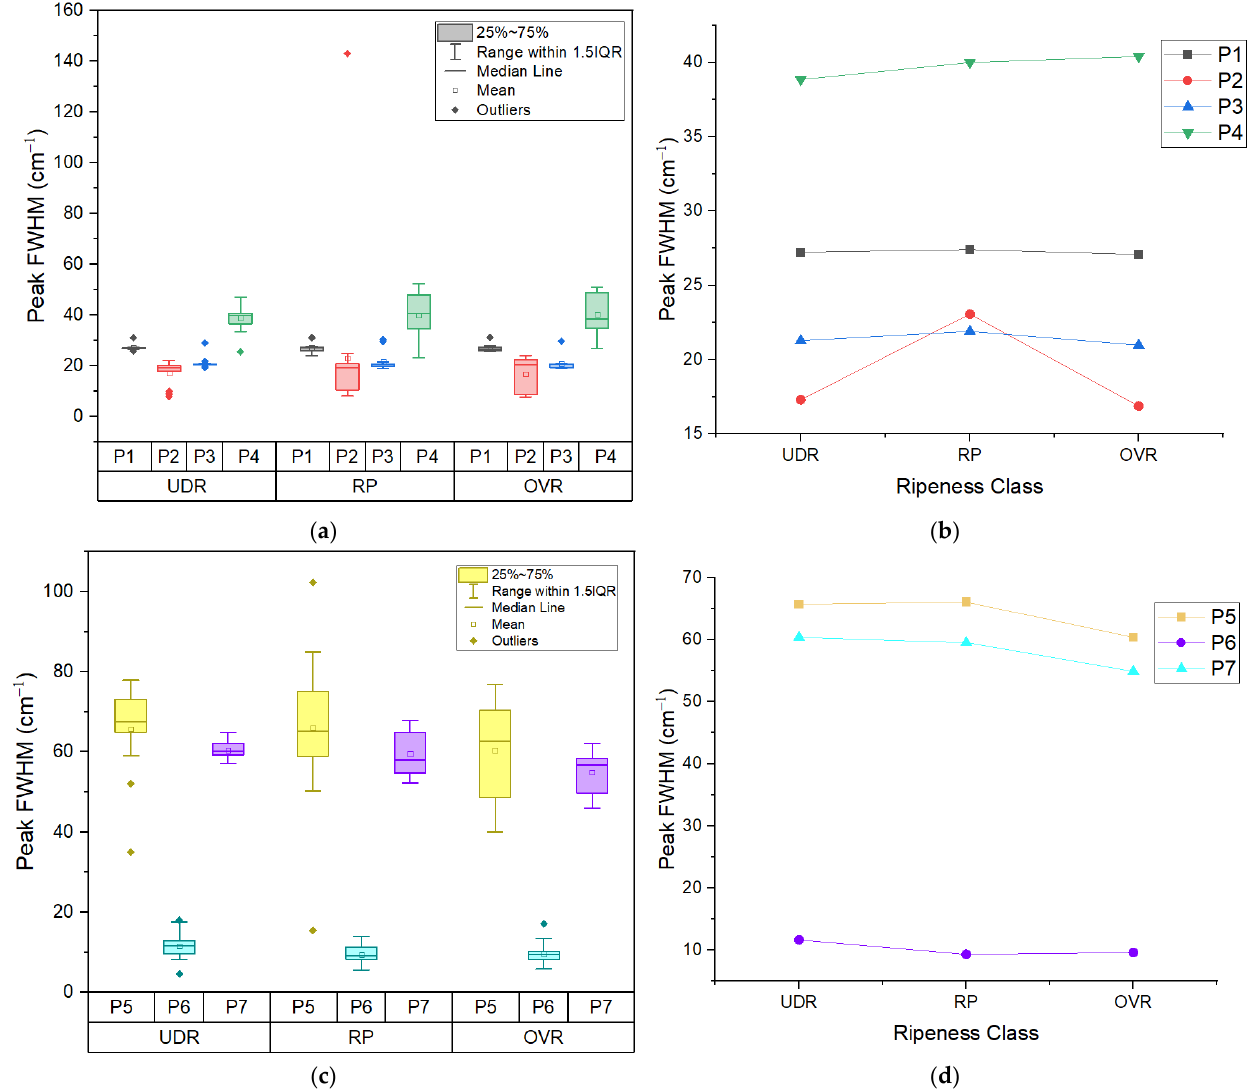
Figure 7. ( a ) Grouped box plot and ( b ) mean plot of peak’s FWHM of 4 peaks in Area 1; ( c ) Grouped box plot and ( d ) mean plot of peak’s FWHM of 3 peaks in Area 2. UDR: Under ripe, RP: Ripe, OVR: Over ripe; P1: β-carotene, P2: chlorophyll-a, P3: β-carotene, P4: amino acid, P5: β-carotene, P6: cu- ticular wax, P7: lycopene/β-carotene. Over ripe; P1: β -carotene, P2: chlorophyll-a, P3: β -carotene, P4: amino acid, P5: β -carotene,